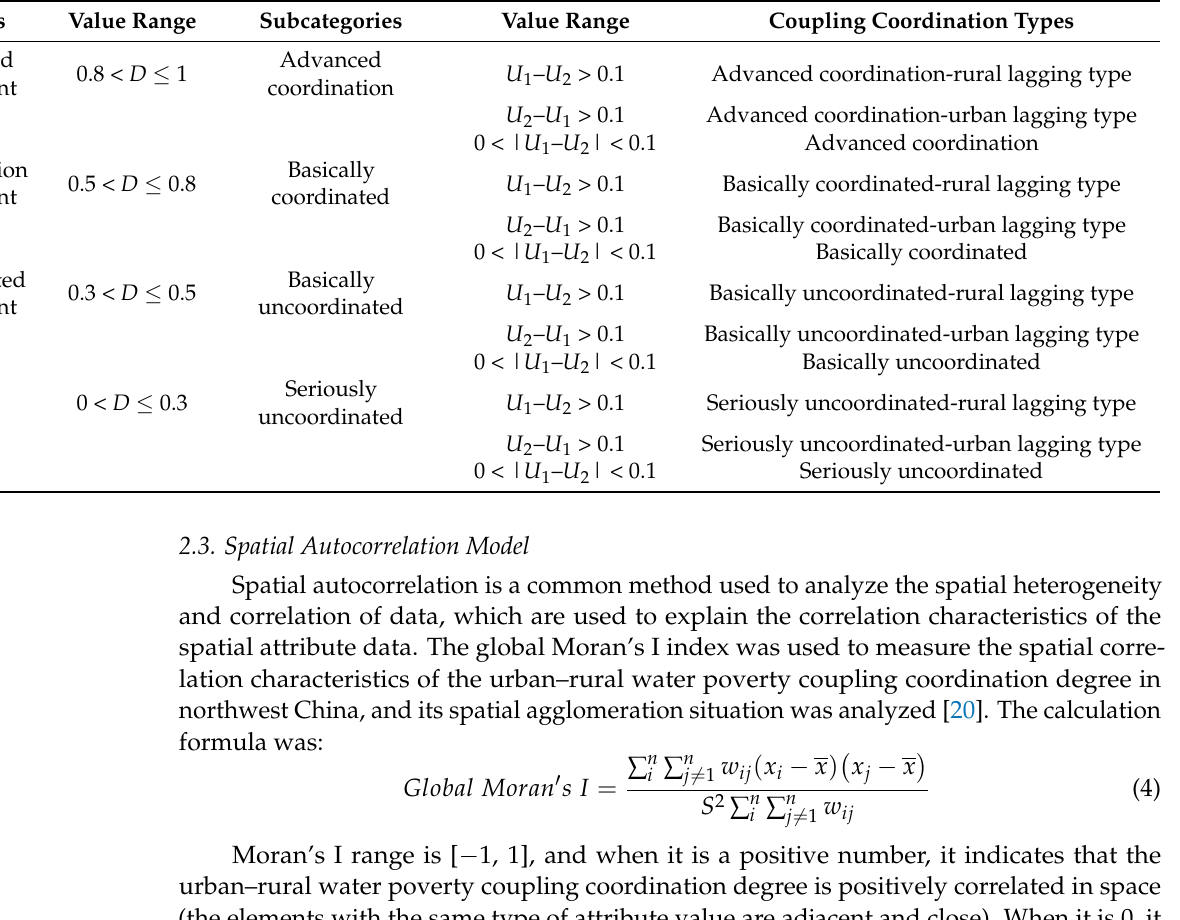
Table 2. The coupling coordination types of urban and rural water